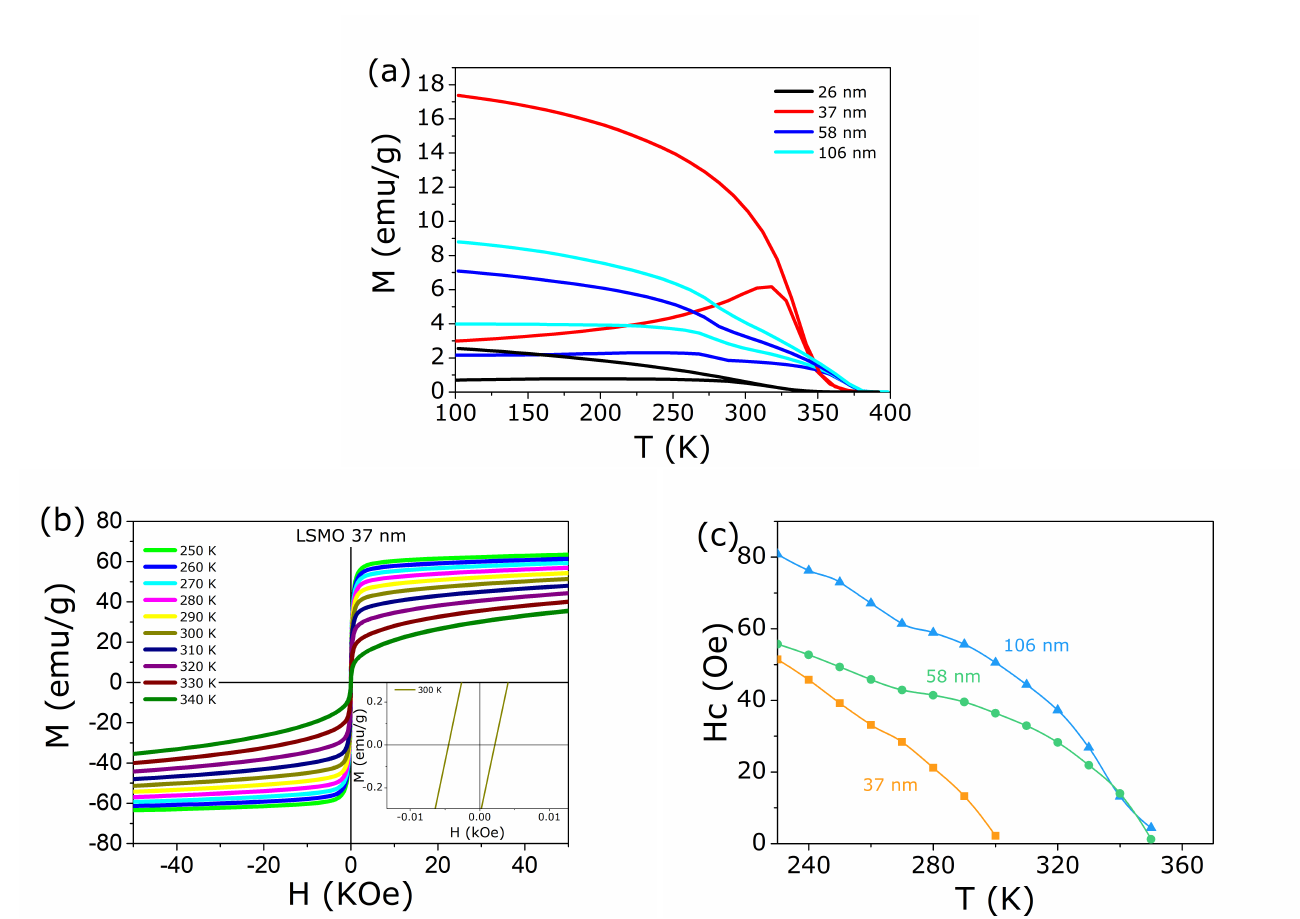
Figure 4. ( a ) ZFC and FC protocols for all samples prepared, with a clear difference for these two methods. It is a direct influence of the NP size on the magnetic properties of these compounds, even being of the same composition. ( b ) Magnetization as a function of magnetic field below the critical temperature, for several values of temperature. This result is representative for the other samples. Note the hysteresis (inset). ( c ) Coercive field as a function of temperature, for all samples prepared: from this result we determine the blocking temperature, as the one in which H c